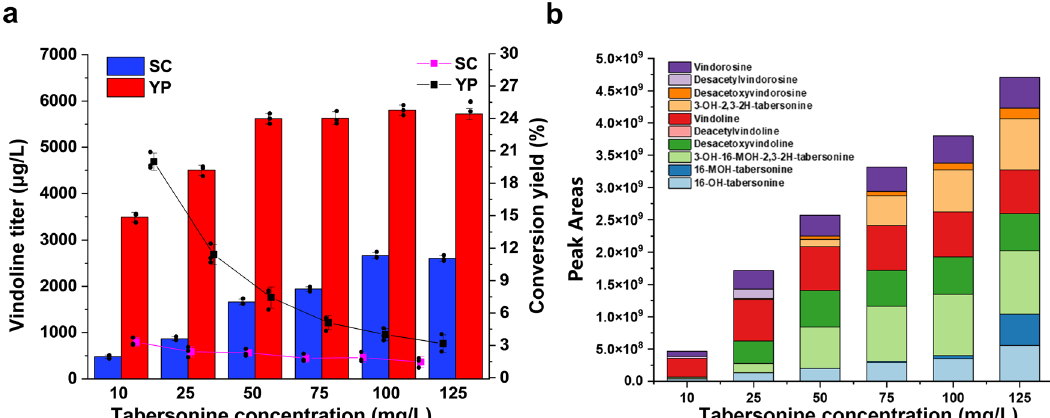
Fig. 6 Effect of tabersonine concentration on the production of vindoline. a The strain (VSY024) was cultured in SC (shown in blue) or YP (shown in red) medium with 2% galactose in the presence of various concentrations of tabersonine at 30 °C. Conversion yield was calculated by the conversion of tabersonine to vindoline, with the pink line representing the conversion yield in SC medium and the black line for that in YP medium. Error bars represent SD of biological triplicates ( n = 3). b The accumulation of vindoline and intermediate metabolites in strain VSY024 when different amounts of tabersonine were supplemented into YP medium. Data are average of biological triplicates ( n =